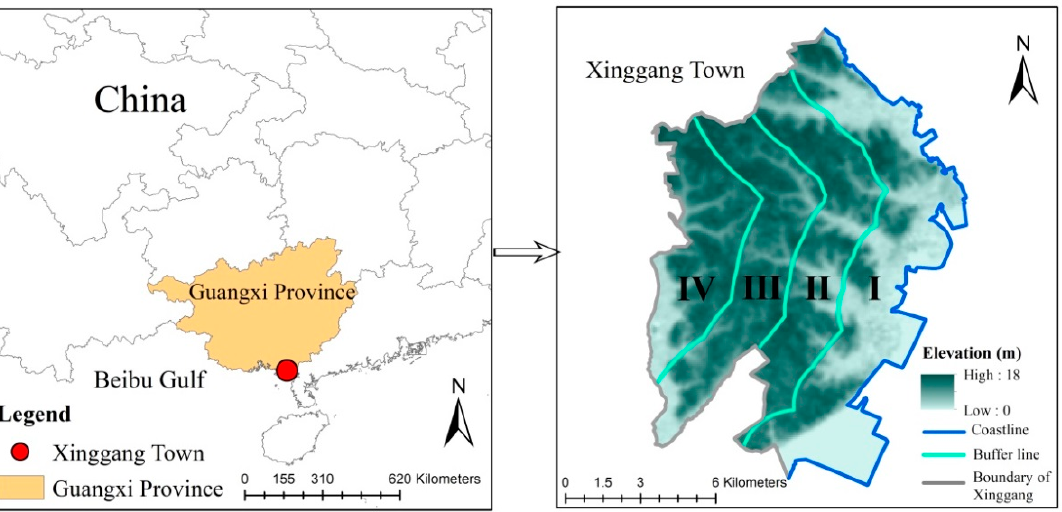
Figure 1. Location of the study area. Data source: derived from standard map provided by the Ministry of Natural Resources of China. (Gradient I (0–2 km), gradient II (2–4 km), gradient III (4–6 km) and gradient IV (>6 km) from the coastline to the